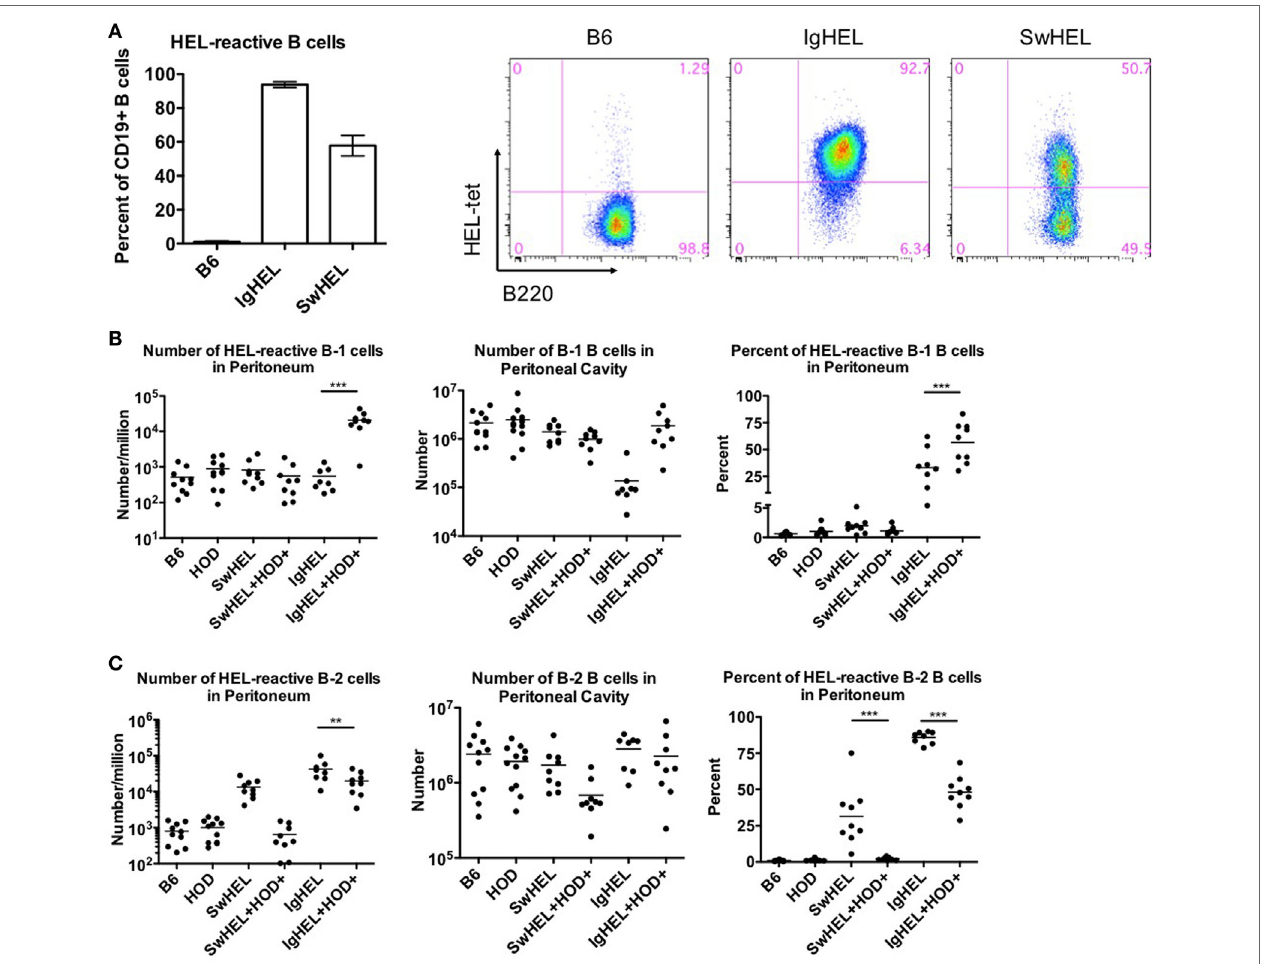
FigUre 1 | B-1 B cells are enriched in autoreactive IgHEL + HOD + but not SwHEL + HOD + . Splenocytes and peritoneal cells were harvested and evaluated for expression of cell surface markers to determine the number, frequency, and phenotype of hen egg lysozyme (HEL)-reactive B cells. (a) Splenocytes from B6 (left), IgHEL (middle), and SwHEL (right) mice were stained with anti-CD19, anti-B220, and fluorescently labeled HEL (HEL-tet) to determine the frequency of HEL-reactive B cells. Data are representative data from three independent experiments (with at least three mice per group), bar graphs are mean ± SD. Bar graphs and flow plots are gated on CD19 + cells. Peritoneal cells were stained with anti-CD19, anti-IgM, anti-CD43, anti-IgD, and HEL-tet to delineate (B) B-1 and (c) B-2 B cell subsets and to determine reactivity with HEL. Data shown in (B,c) are compiled from three independent experiments with at least three mice per group. Selective p values are shown on graphs and * ≤ 0.05, ** ≤ 0.01, and *** ≤ 0.001. For complete statistical analysis with all significant differences, see Table S1 in Supplementary